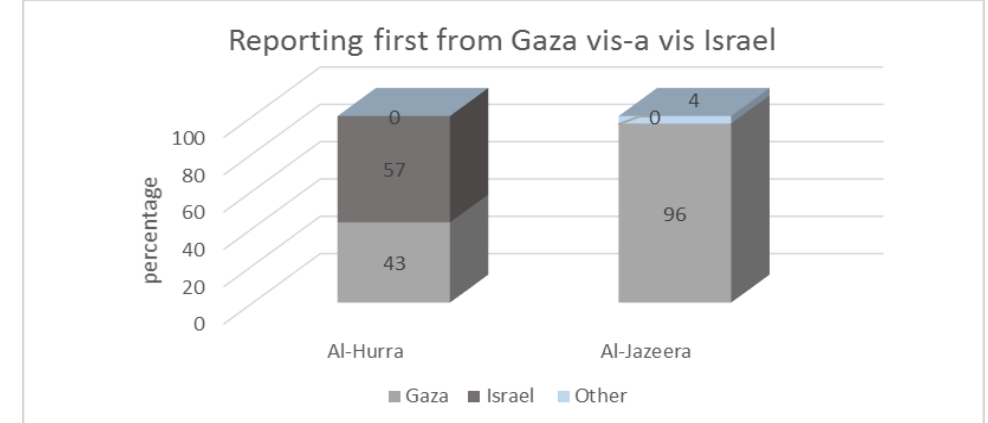
Figure 5. The reporter who spoke first in the news.